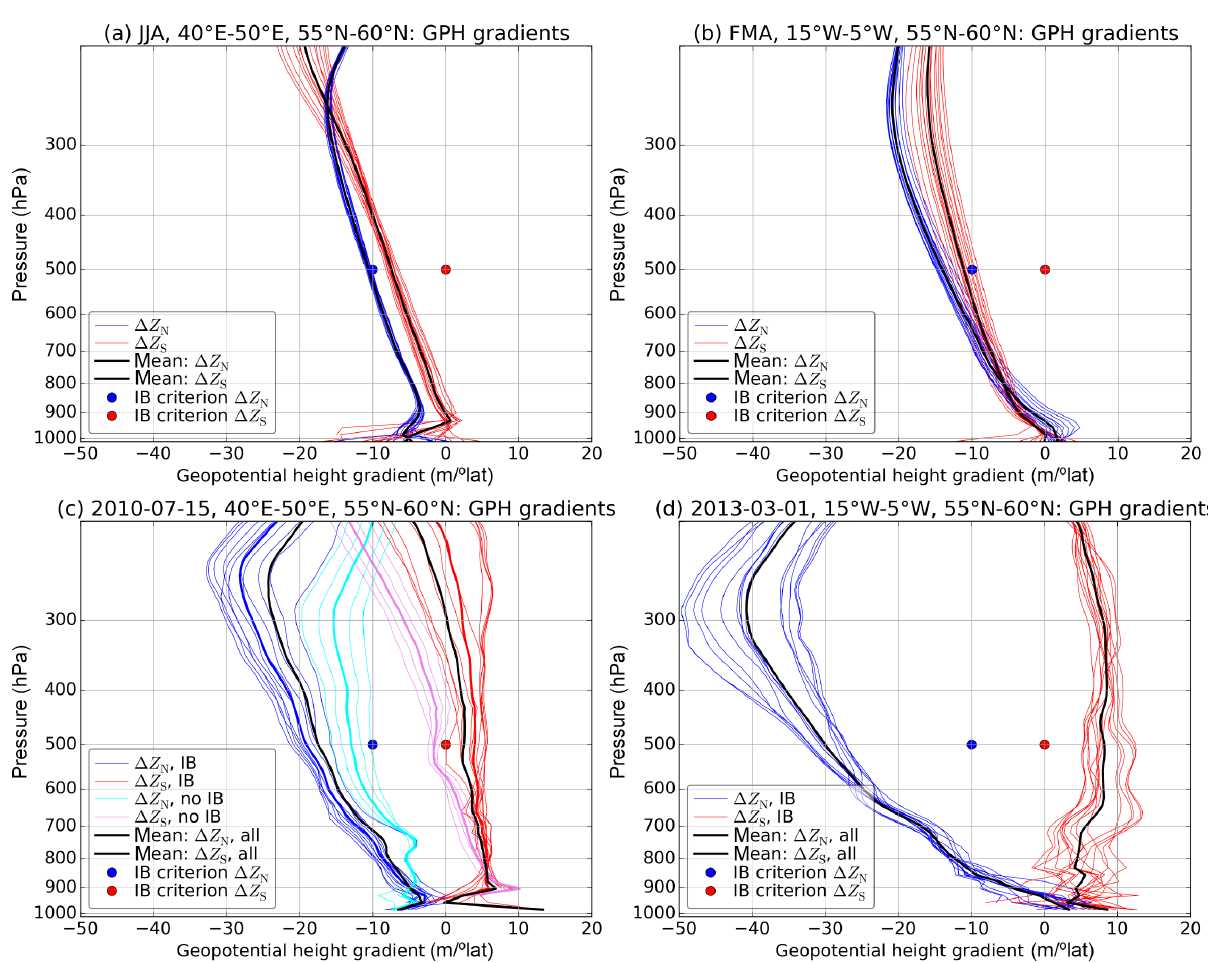
Figure 4. Vertical profiles of (blue) (cid:49)Z N and (red) (cid:49)Z S during climatological conditions in (a) JJA 2006 to 2013 within 40 to 50 ◦ E and 55 to 60 ◦ N and (b) FMA 2006 to 2013 within 15 to 5 ◦ W and 55 to 60 ◦ N. (cid:49)Z N and (cid:49)Z S are given for individual grid cells (thin lines) and the respective region mean (bold lines). IB blocking criteria at 500hPa are shown for (cid:49)Z N (blue dot) and (cid:49)Z s (red dot). Vertical profiles of GPH gradients for an exemplary day during the (c) Russian blocking and (d) Greenland blocking; same area as (a) and (b) , respectively. Blocked profiles (blue, red) and those not meeting the blocking criteria (light blue, light red) are shown, as are mean (bold colored) and all-mean (bold black) (cid:49)Z N and (cid:49)Z S profiles. Note that the mean is identical with the “all-mean” for the Greenland